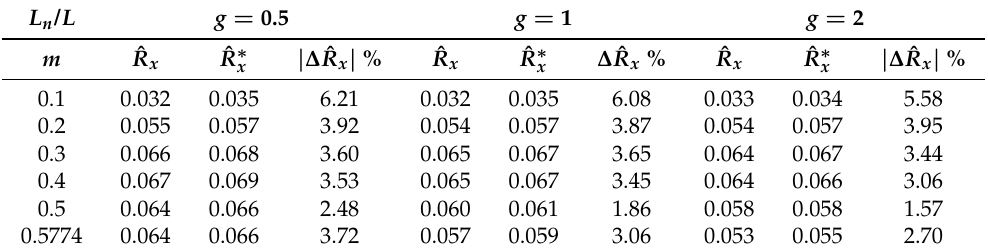
Figure 11. Experimental validation of normalized phase-current-ripple RMS in the case of DPWM1 for L n = L /2, L n = L , and L n = 2 L (i.e., g = 0.5, g = 1, and g = 2). Normalization base V dc / ( 2 Lf sw ) . Table 6. Phase-current-ripple RMS experimental errors assessment in the case of DPWM1 for L n = L /2, L n = L , and L n = 2 L (i.e., g = 0.5, g = 1, and g = 2).